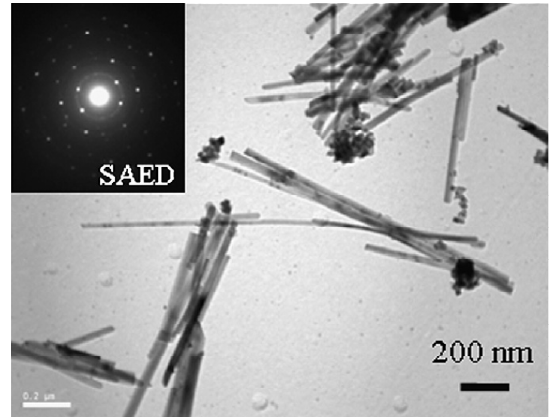
Figure 3. TEM image for magnetite nanowires synthesized with poly(ethylene glycol) O (1:2 by volume) at 150 °C for 24 h in an autoclave. The selected area electron (PEG)/H 2 diffraction (SAED) pattern is shown in the inset. Reprinted with permission from [19]. Copyright 2008 Elsevier